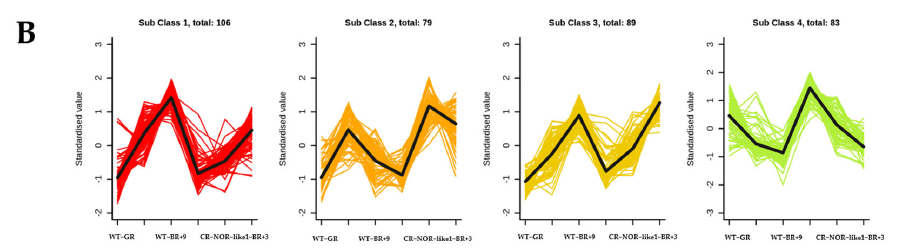
Figure 2. ( A ) Cluster heat map of differential-metabolite content; horizontal is the sample name, vertical is the metabolite information, Group is the grouping, Class is the substance classification, and different colors are the values obtained after normalization of the relative content (red represents high content, green represents low content). ( B ) K-means clustering diagram of differential metabolites; the horizontal coordinate indicates the sample name, the vertical coordinate indicates the normalized relative metabolite content, Sub Class represents the metabolite class number with the same trend of change, and total represents the number of metabolites in the class as.